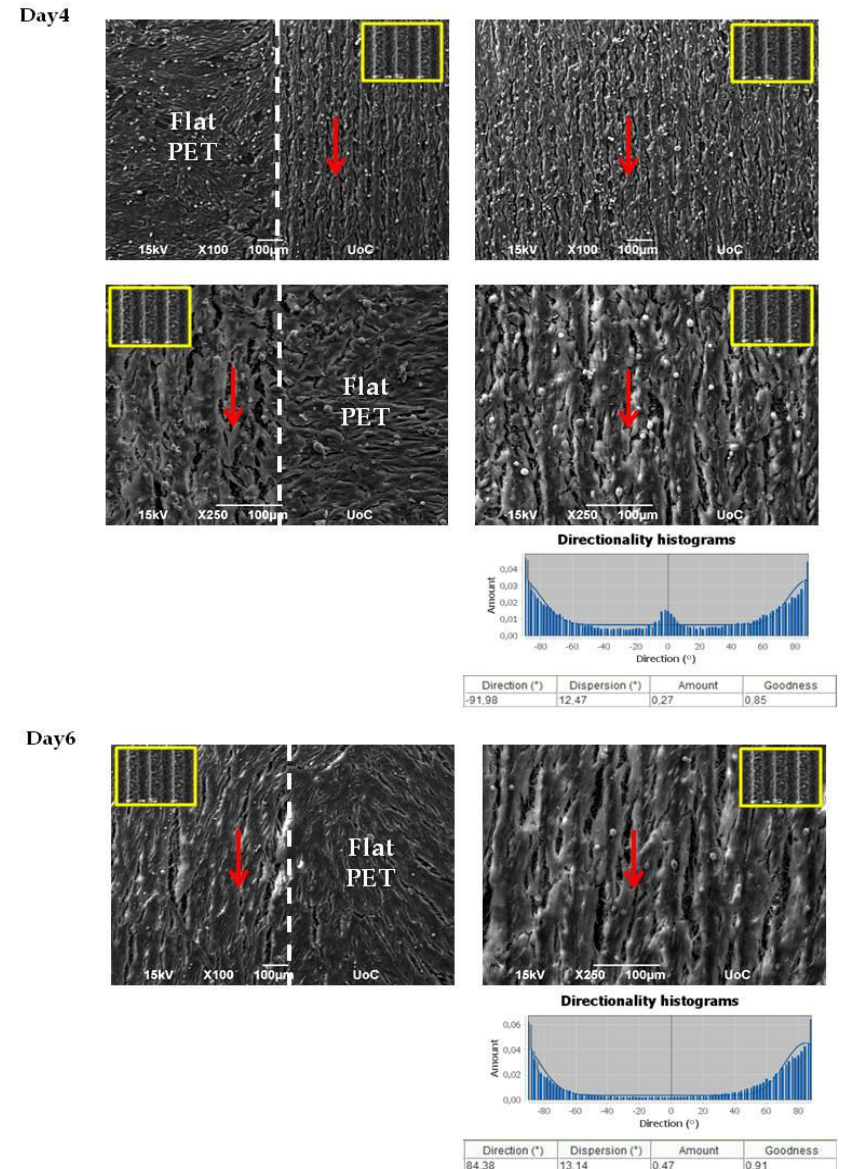
Figure 5. Scanning electron microscopy (SEM) images of Schwann cells cultured on the PET substrates (PET-MG and PET-Flat) for 4 and 6 days. The red arrows represent the directionality of Schwann cells, which are oriented according to the direction of the microgrooves. The inset SEM images, indicated by the yellow box, show the geometry of microgrooves. Under the SEM images, directionality histograms and the tables with statistics are presented, which were generated using the Fiji ImageJ plug-in “Directionality” [43]. Above the histogram, the plug-in generates statistics for the highest peak found. The highest peak is fitted by a Gaussian function, taking into account the periodic nature of the histogram. In the tables, the “Direction (°)” column reports the center of the Gaussian; the “Dispersion (°)” column reports the standard deviation of the Gaussian; the “Amount” column is the sum of the histogram from center-std to center+std, divided by the total sum of the histogram; the “Goodness” column reports the goodness of the fit, where 1 is good, 0 is bad.